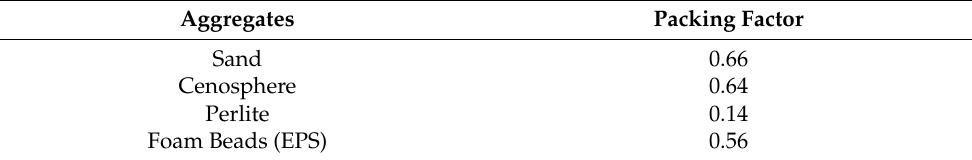
Table 3. Packing factor values of the